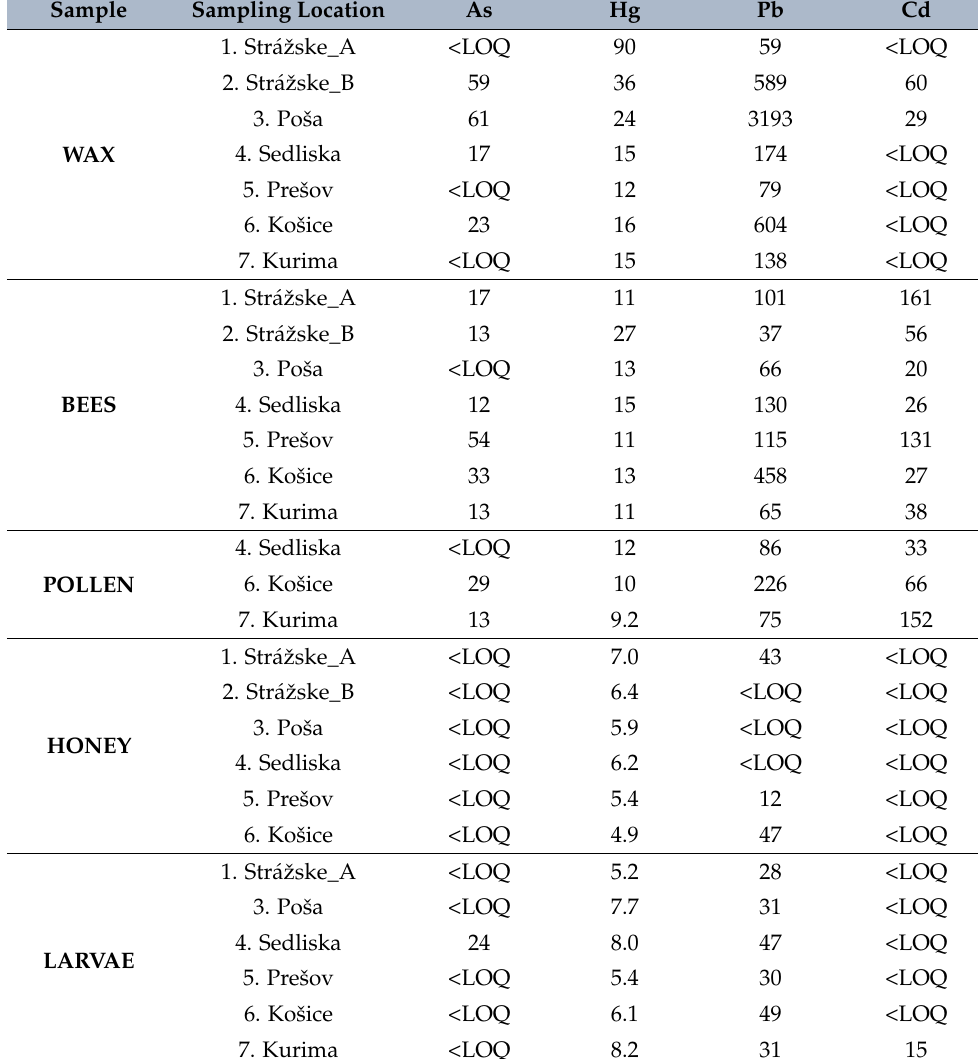
Table 1. Content ( µ g/kg) of toxic trace